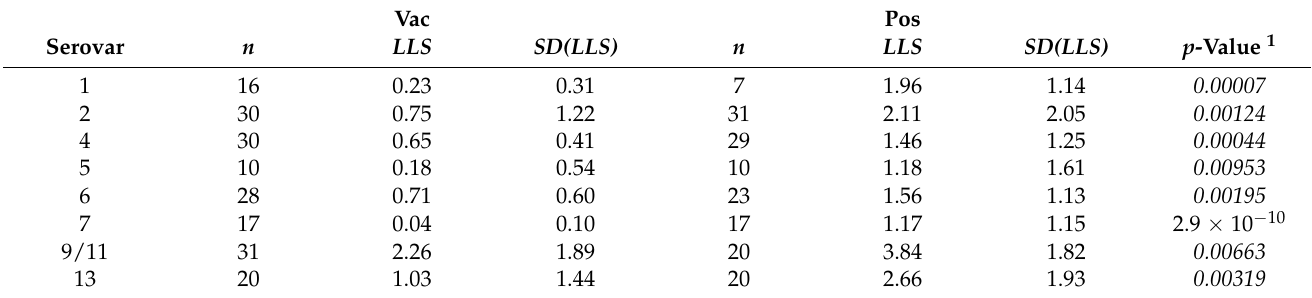
Table 2. Results presented by sample size, mean weighted Lung Lesion Score (LLS) and standard deviation (SD) for the vaccinated, challenged (Vac) groups and the non-vaccinated, challenged (Pos) groups for A. pleuropneumoniae serovars 1, 2, 4, 5, 6, 7, 9/11, and 13. The p -value is for the test of a difference between Vac and Pos within each A. pleuropneumoniae serovar. Significance is considered when the p value <